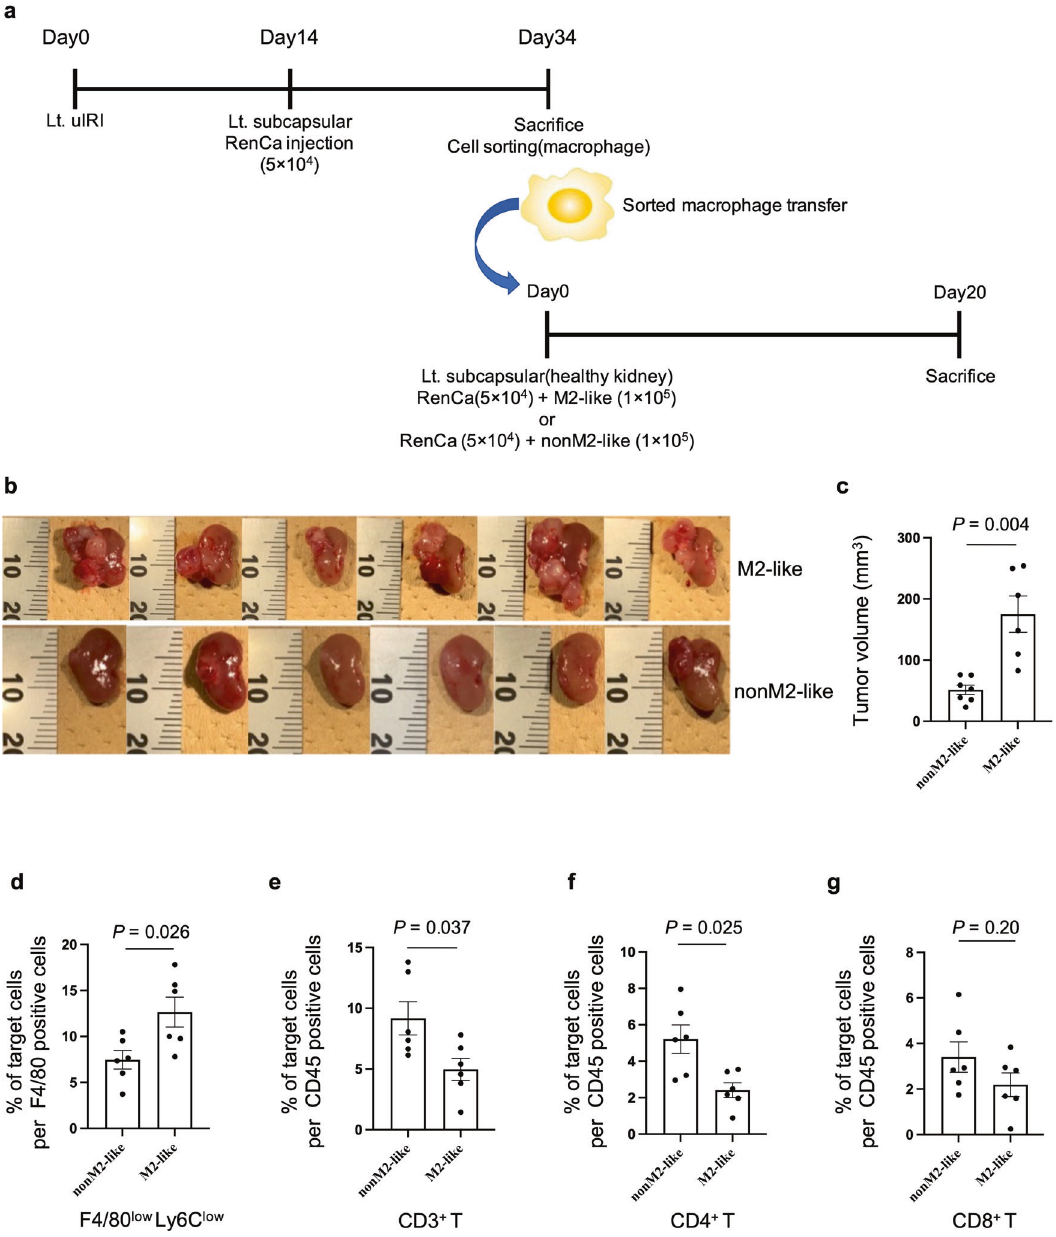
Fig. 2 Adoptive transfer of M2-like macrophages from kidney cancer reproduces the immunosuppressive tumor microenvironment. F4/ 80 low Ly6C low (M2-like) or F4/80 high Ly6C low (nonM2-like) macrophages, which were sorted from uIRI-Can, were co-injected with RenCa cells into healthy kidney subcapsule. Tumor progression was evaluated 20 days after co-injection. a The protocol of this experiment is shown. b , c Tumor volume of M2-like macrophage co-injected kidney cancer and nonM2-like macrophage co-injected kidney cancer is shown. ( n = 6 per group; two-sided Mann – Whitney U test). d Intra-tumor F4/80 low Ly6C low macrophage proportion in F4/80 + cells was quantitatively evaluated in M2-like macrophage co-injected tumor and non-M2-like macrophage co-injected tumor, as determined by fl ow cytometer. ( n = 6 per group; two-sided Mann – Whitney U test). Tumor-in fi ltrating CD3 + T cells ( e ), CD4 + T cells ( f ), and CD8 + T cells ( g ) proportion in CD45 + cells were quantitatively evaluated in M2-like macrophage co-injected tumor and non-M2-like macrophage co-injected tumor, as determined by fl ow cytometer. ( n = 6 per group; two-sided Mann – Whitney U test). Lt. left side, uIRI unilateral ischemia-reperfusion